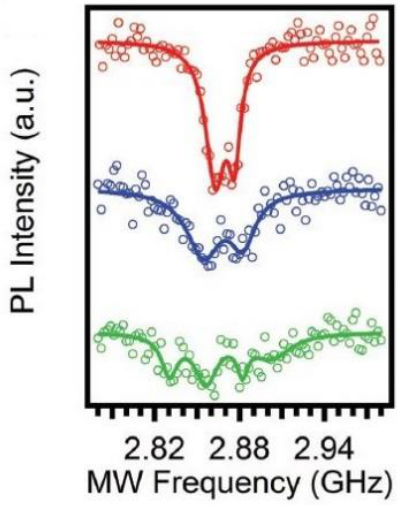
Figure 11. ODMR spectra under external magnetic field: zero-field (red curve), 1 mT (blue curve), and 3 mT (green curve). The circles are the experimental data while the lines are multi-gaussian fits. Adapted with permission from [82], Royal Society of Chemistry, 2016.